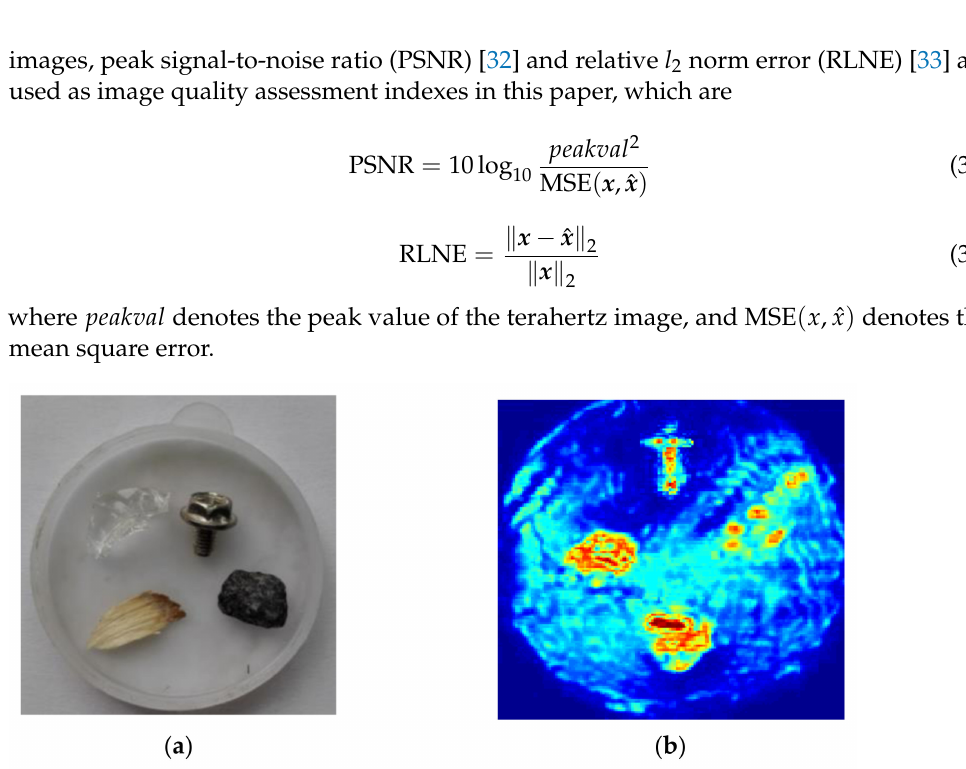
Figure 1. The sample and the terahertz image obtained through full scan imaging process. ( a ) sample; ( b ) terahertz